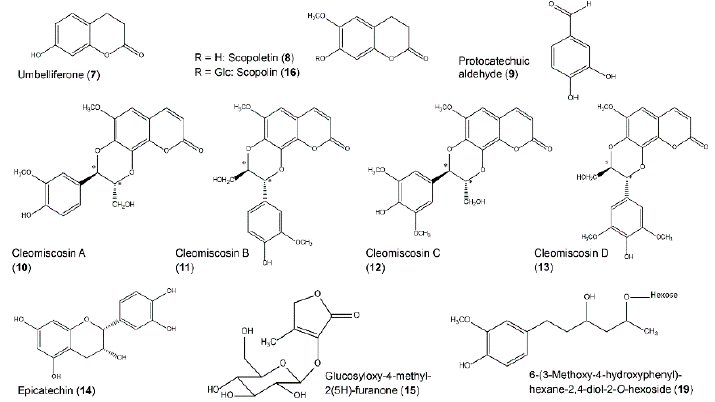
Figure 3. Structures of compounds 7 – 16 and 19 isolated from the acetone-water (7:3) extract of the roots of P. pinnata . roots of P. pinnata